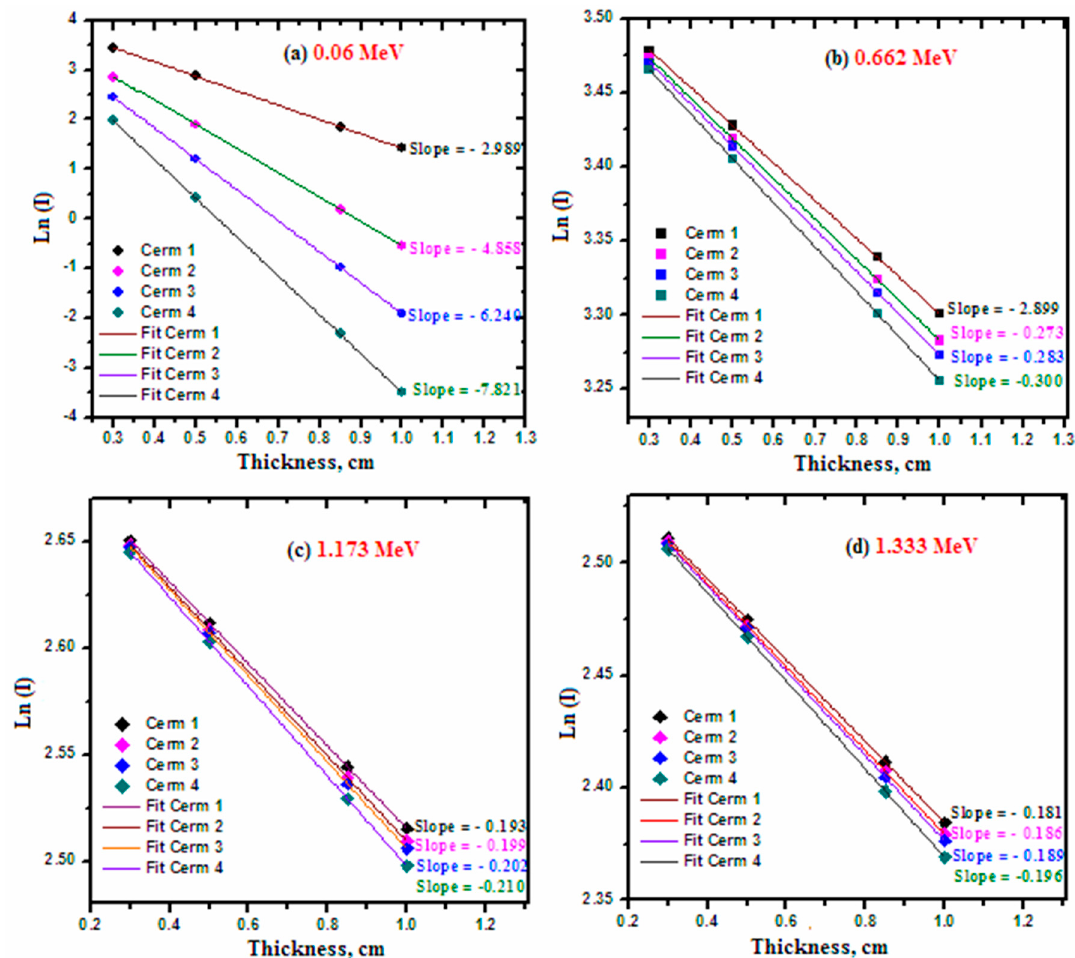
Figure 4. Relation between ln(I) and the thickness of the ceramic samples.